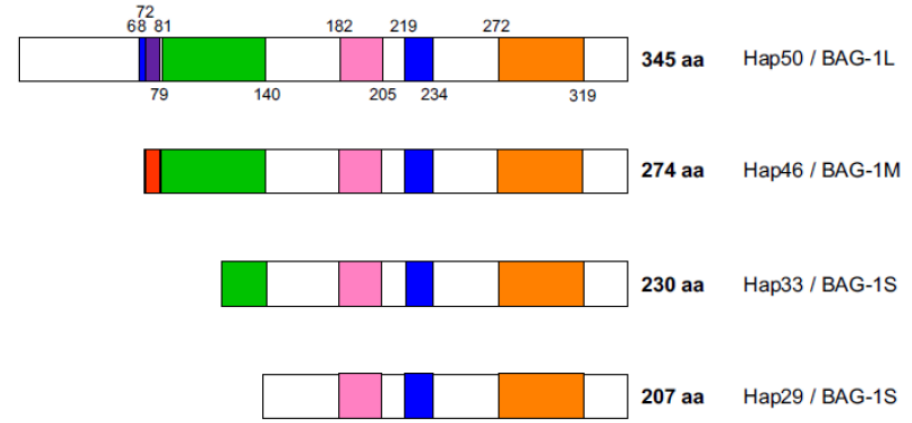
Figure 1. Domain structure of polypeptides. Blue : potential nuclear localization signals; red : basic DNA-binding domain. The sequence in Hap46/BAG-1M is (1)Met-Lys-Lys- Lys-Thr-Arg-Arg-Arg-Ser-Thr(10). Due to overlap with a potential nuclear localization signal, this appears purple in Hap50/BAG-1L; green : acidic hexarepeat domain, consensus sequence: Thr-Arg-Ser-Glu-Glu-X; pink : ubiquitin-like domain; orange : hsp70/hsc70 binding domain or BAG-domain (shown here as originally defined